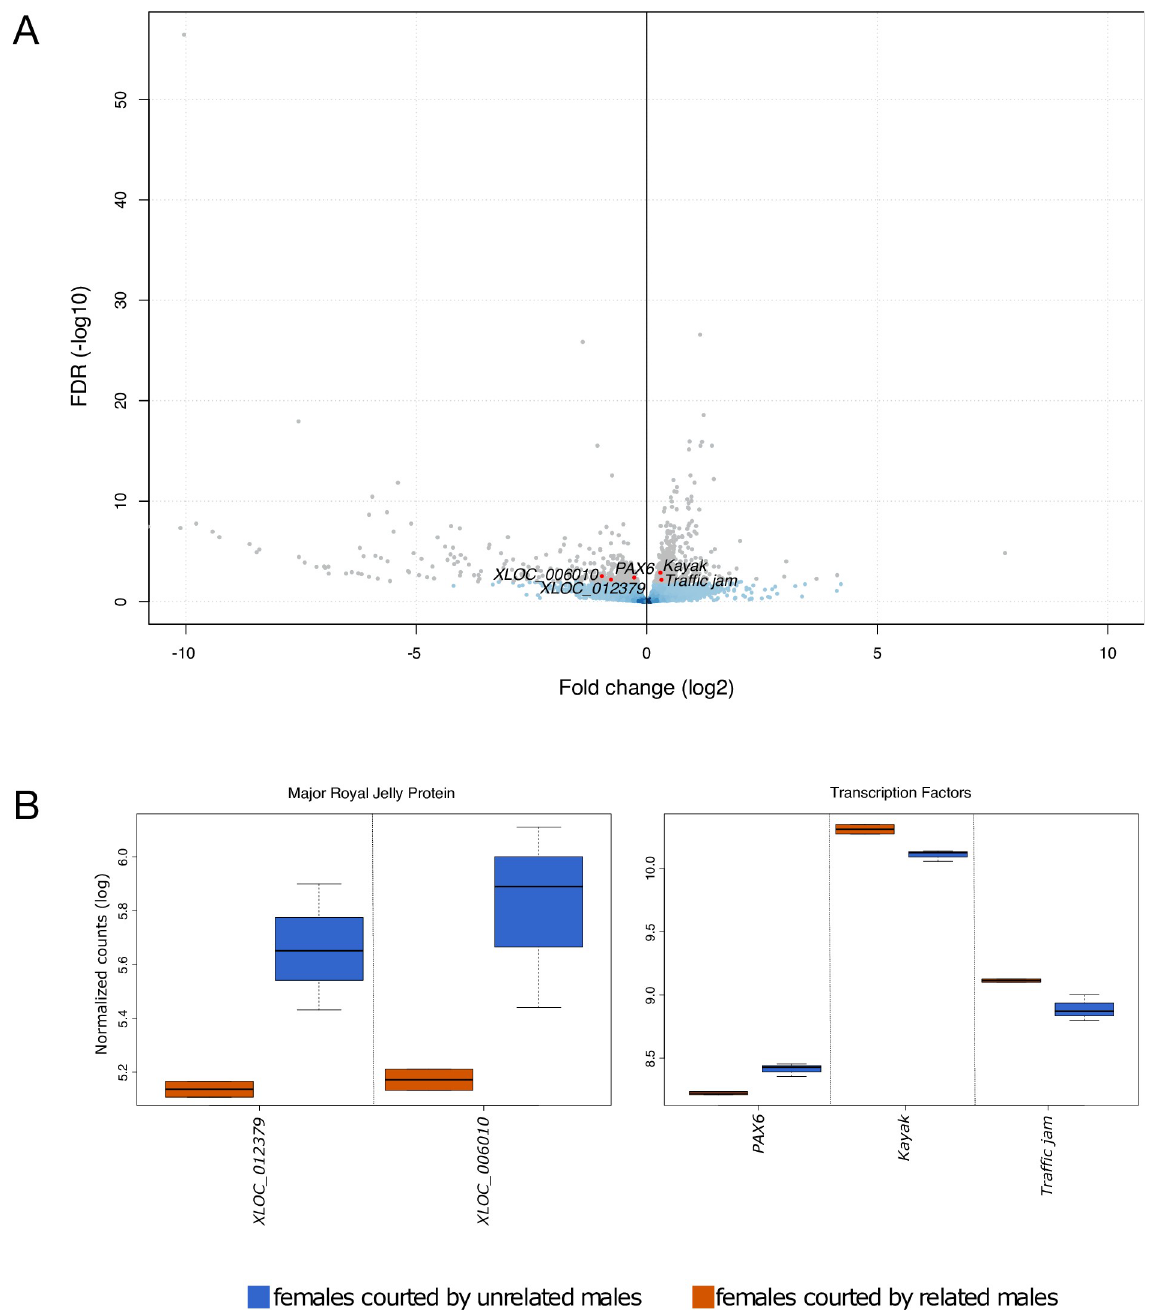
Fig 3. Influence of relatedness of courting males on females’ transcriptome expression: 5.9% of the total transcriptome (grey) was regulated according to the relatedness of the courting male. ( A ) Comparison of females courted by related males to females courted by unrelated males showed 481 genes overexpressed in females courted by related males (positive fold change values) and 350 genes overexpressed in females courted by unrelated males (negative fold change values). ( B ) Boxplot showing significant expression changes according to the relatedness of the courting male for highlighted genes mentioned in the text. The X axes indicate gene names, Y axes show normalized counts after log transformation, and boxplot whiskers show the range of read counts between biological replicates. Yellow—mrjp : yellow major royal jelly proteins; PAX6 : paired box